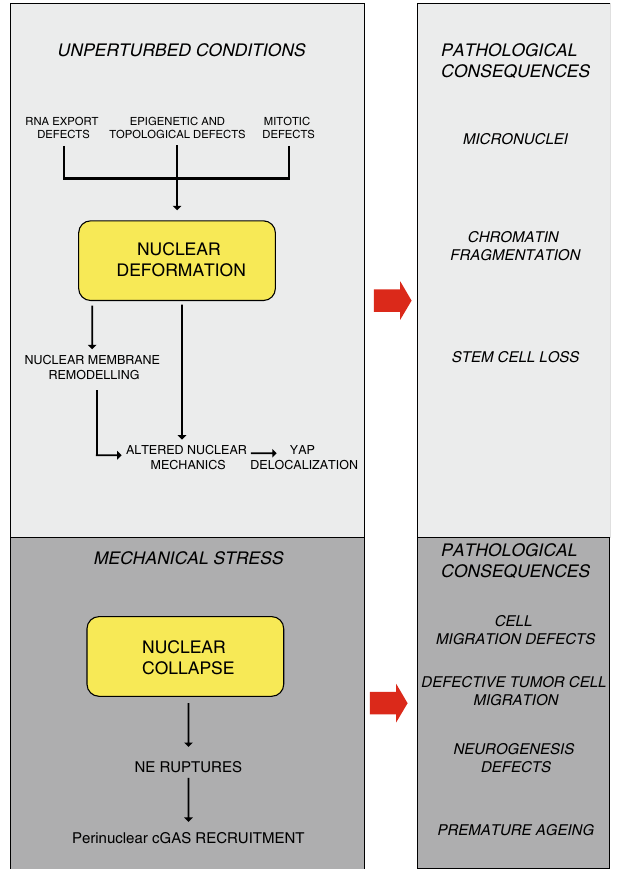
Fig. 7 Graphical summary of ATR defects affecting nuclear morphology and mechanics and relative pathological consequences. In the absence of external stimuli ATR coordinates chromatin processes (such as RNA export, epigenetic and topological transitions, and chromatin condensation in prophase) with NE dynamics, in fl uencing nuclear morphology. ATR defects lead to nuclear deformation, NE remodeling, altered nuclear mechanics, and YAP delocalization. In response to mechanical stress, ATR-defective nuclei collapse leading to NE ruptures and cGAS recruitment at the nuclear periphery. Pathological consequences are also described. See text for